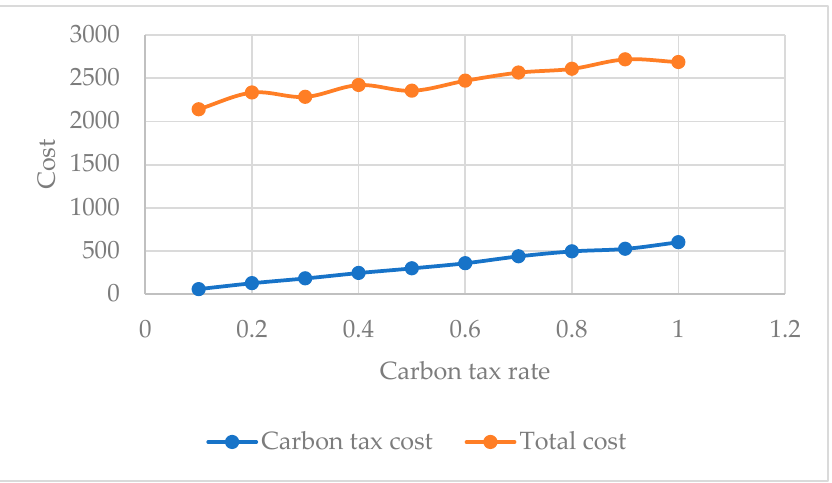
Figure 13. The carbon emission cost and total cost with different carbon tax rates.